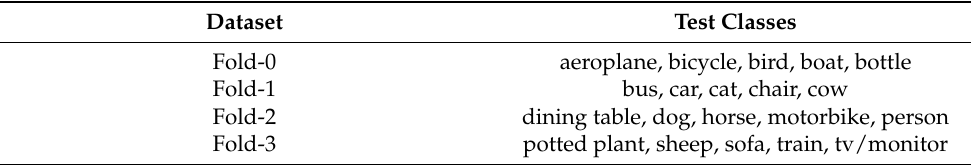
dining table, dog, horse, motorbike,